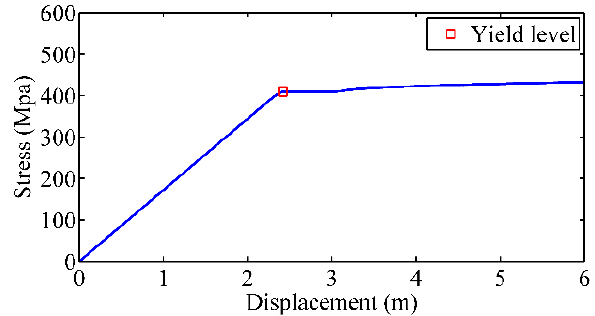
Figure 3. Relation between tower base stress and the nacelle displacement.